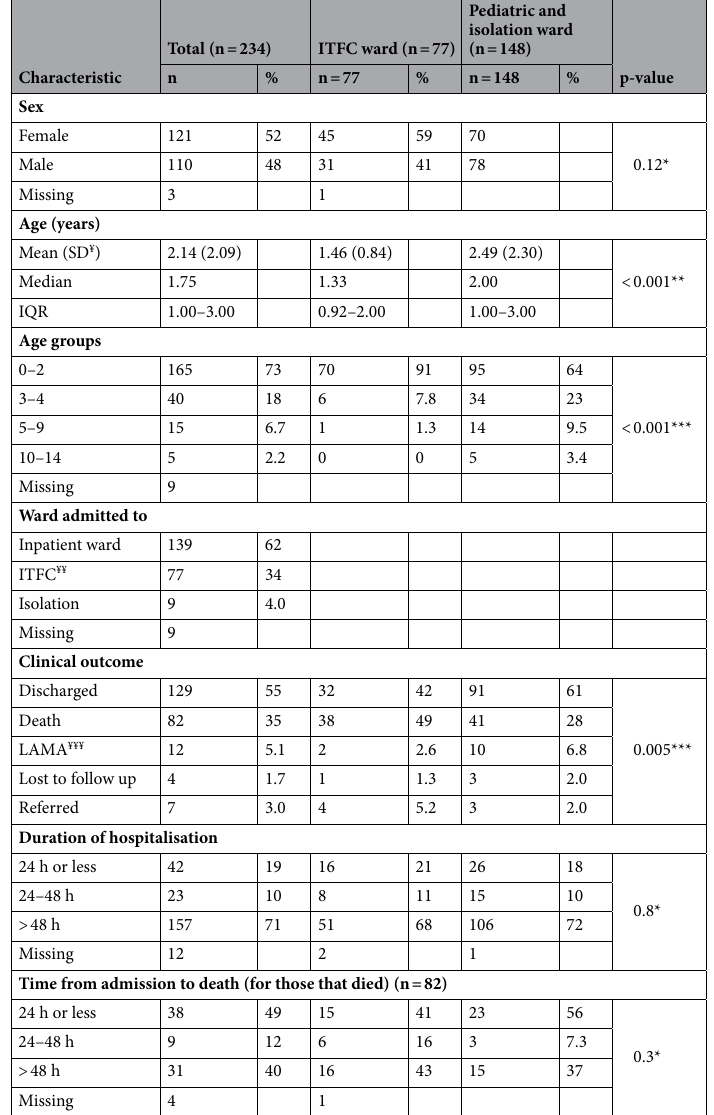
Table 1. Epidemiological characteristics of pediatric patients admitted with severe sepsis in AGH between November 2018 and August 2020. ¥ SD standard deviation, ¥¥ ITFC Inpatient Therapeutic Feeding Centre, ¥¥¥ LAMA Left Against Medical Advice, *Chi-square test of independence, **Wilcoxon rank-sum test, ***Fisher’s exact